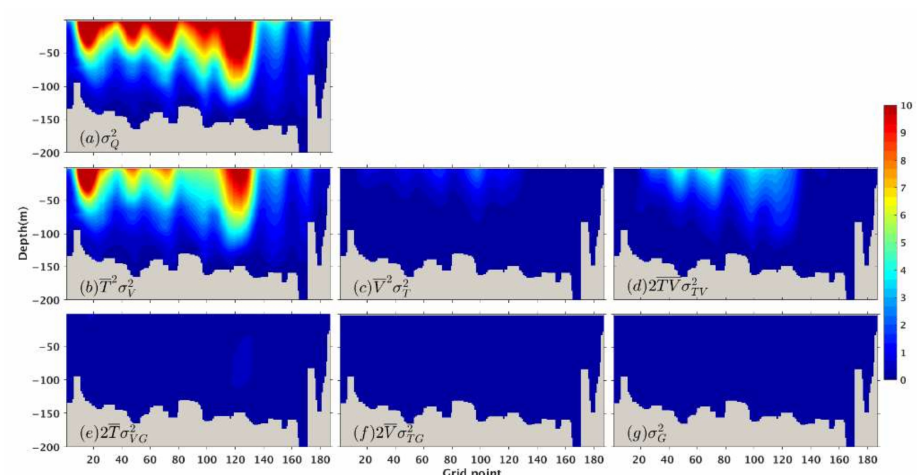
Figure 9. ( a ) denotes the total variance in heat transport across the SBS. ( b – g ) represent the six terms decomposed using Equation (13).